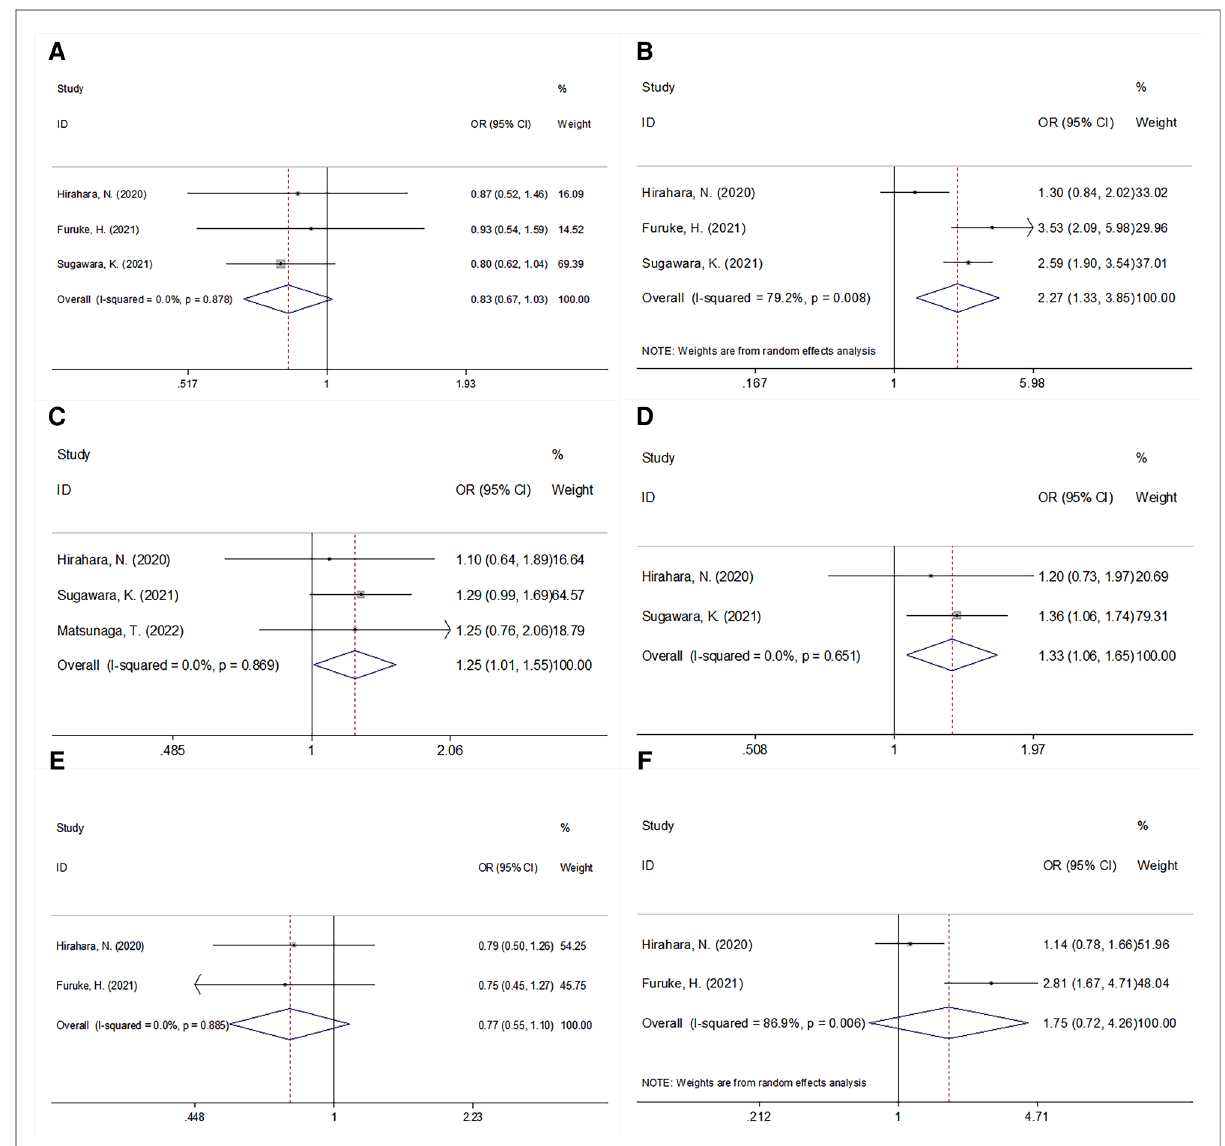
FIGURE 4 Forrest plots of the relationship between GNRI and clinicopathological features in patients with GC. ( A ) Gender (male vs. female); ( B ) pathological stage (III vs. I – II); ( C ) adjuvant chemotherapy (presence vs. absence); ( D ) tumor location (lower vs. upper+middle); ( E ) tumor differentiation (poor